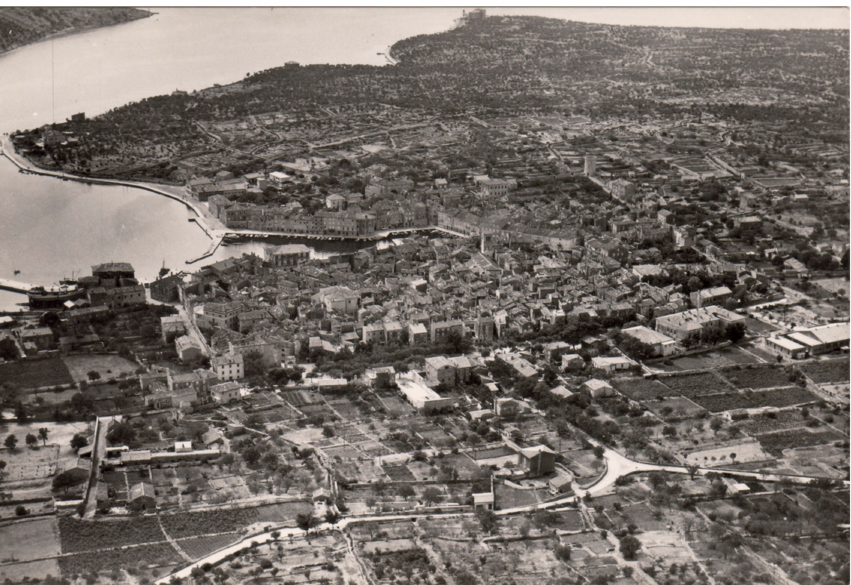
Figure 16. One of the rare high-quality photographs taken in mid-twentieth century. Besides the paths that lead from town to olive grove parcels, an arable crop land close to the town is discernible, which is today mostly ground for new housing construction (D. Renduli´c—Agencija za fotodokumentaciju Zagreb,